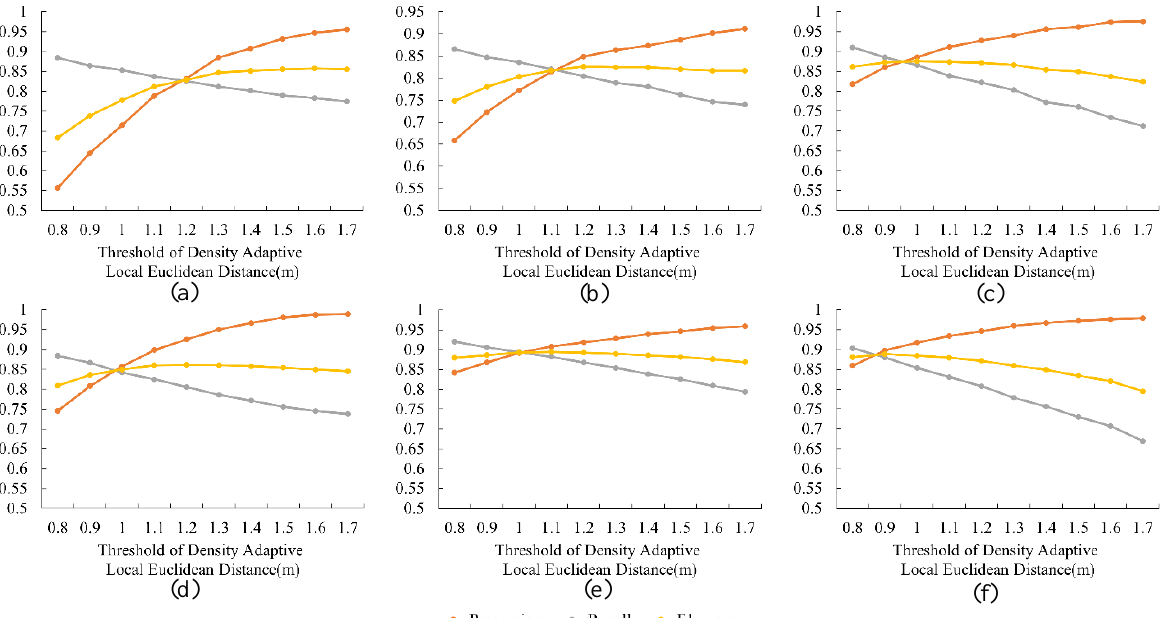
Figure. 7 Variation of change detection accuracy with 𝑇 for the proposed method: (a) is result of the first phase point clouds of area 𝑑 1, (d) is the result of the second phase point clouds of area 1, (b) is the result of the first phase point clouds of area 2, (e) is the result of the second phase point clouds of area 2, (c) is the result of the first phase point clouds of area 3, (f) is the result of the second phase point clouds of area